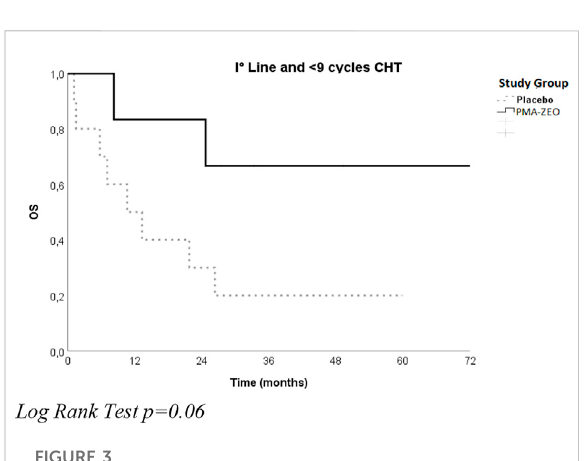
FIGURE 3 Overall survival for the study groups (Placebo vs.